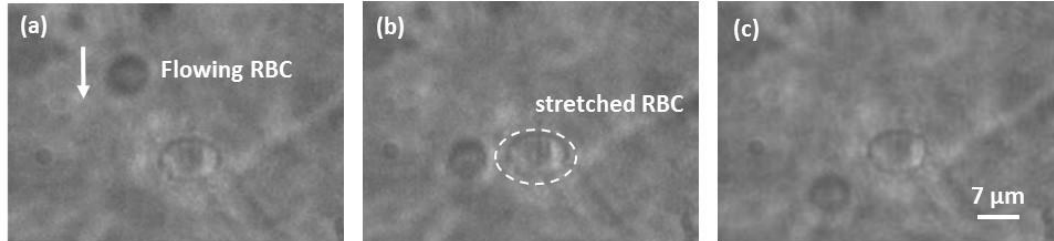
11 of 13 Figure 10. Microscope images of PMMA microinjected channels with no chloroform treatments ( a ) and with exposures times of ( b ) 2 minutes, ( c ) 4 minutes and ( d ) 6 minutes. For the device demonstration, a traditional optical stretcher setup was used. The laser source was a continuous wave ytterbium fiber laser (YLD-5k-1070, IPG Fibertech, Srl, Legnano, Mi, Italy) emitting up to 5 mW at 1070 nm. The output beam was split into two single mode fibres (HI-1060- Corning Incorporated, Corning, NY, USA) by a 50%-50% fibre coupler. The chip was mounted on to a phase contrast inverted microscope (Leica, Wetzlar, Germany) to capture the particles flowing, trapped and stretched in the microfluidic channel. The phase contrast images were acquired by a Charge-Coupled Device camera (DFC310 FX, Leica, Wetzlar, Germany) through a bandpass optical filter that cuts the infrared (IR) light (FGS550, Thorlabs, Newton, NJ, USA) [6]. A preliminary test was done by inserting a solution of polystyrene microbeads (7 µm diameter) inside the microfluidic channel. It was possible to trap the micro-beads with less than 7 µW laser power on each branch. Figure 11 shows the phase contrast microscope images of a trapped bead with the IR light filter inserted (a) or not (b), in order to demonstrate that the bead was trapped due to the light beams out coming from the crossing optical fibres, impinging onto the bead surface from both sides. Figure 11. Image of a trapped polystyrene bead (7µm diameter) with the microscope infrared light (IR) light filter inside ( a ) or out ( b ). In ( b ) the scattering visible on both sides of the bead demonstrates the trapping due to the light from the optical fibres. The final trapping and stretching test was done using red blood cells (RBC). In order to obtain a sample of quasi-spherical RBCs with 8 µm diameter, we diluted 10 µL of blood in 8 mL of hypotonic solution. With a quasi-spherical cell, it will be easy to demonstrate stretching, as the cell profile will